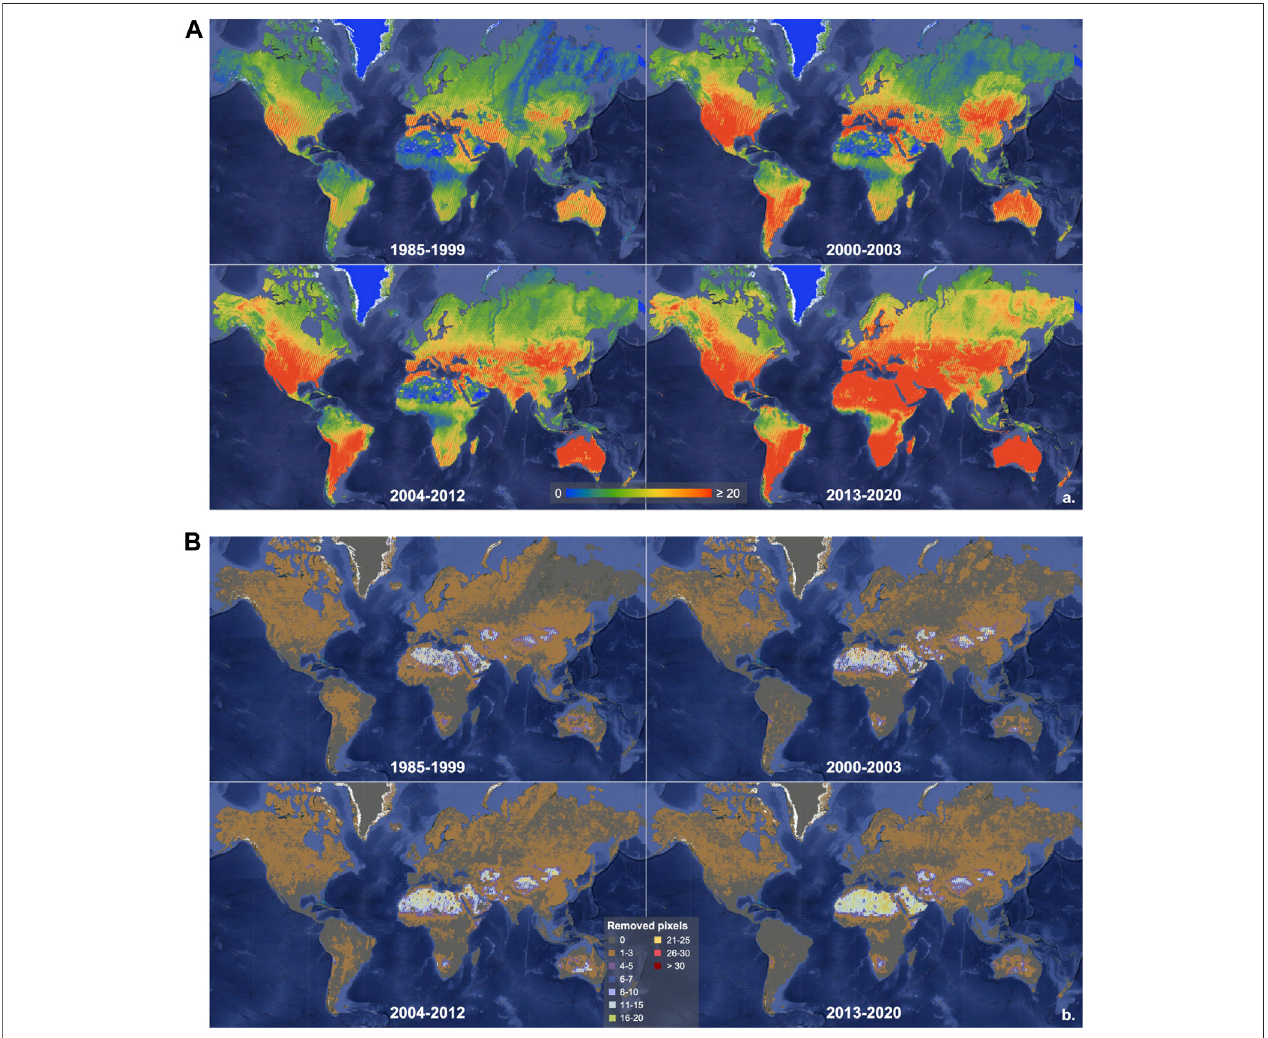
FIGURE5|(A) Averagenumberofannualobservationswhenusingthesr_atmos_opacitybandwithoutconsideringtheLEDAPSfailingpixels. (B) Averagenumber of observations removed per year when no AOT information is available. The difference is between maps in Figures 4A , 5A .